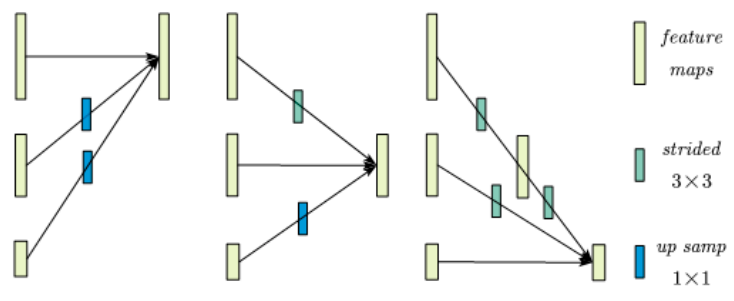
Figure 2. The switching